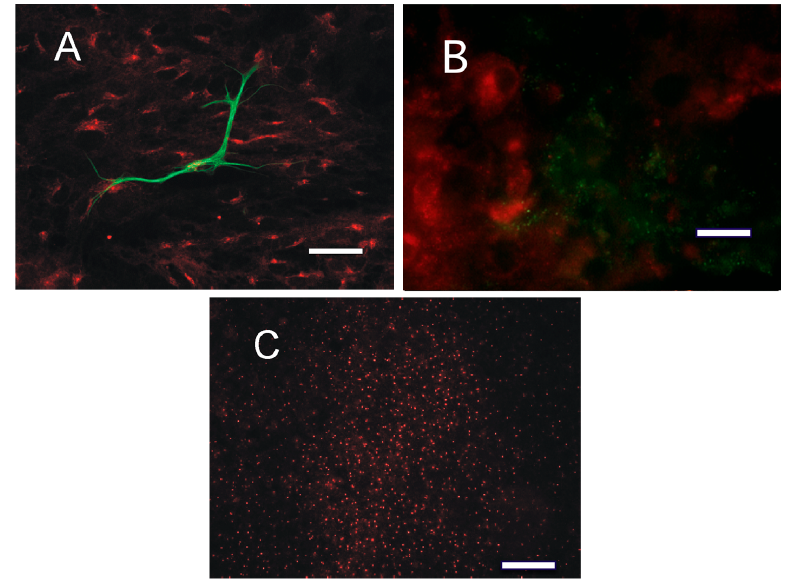
Figure 5. ( A ) Primary culture from glial cells: R2 (red) and glial fibrillary acidic protein (GFAP; green).